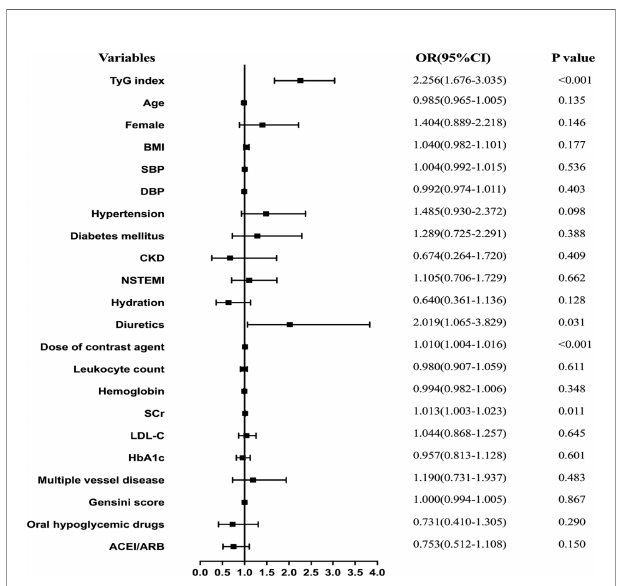
FIGURE 2 | Forest plot of the multivariable logistic regression analysis exploring the association between the TyG index and